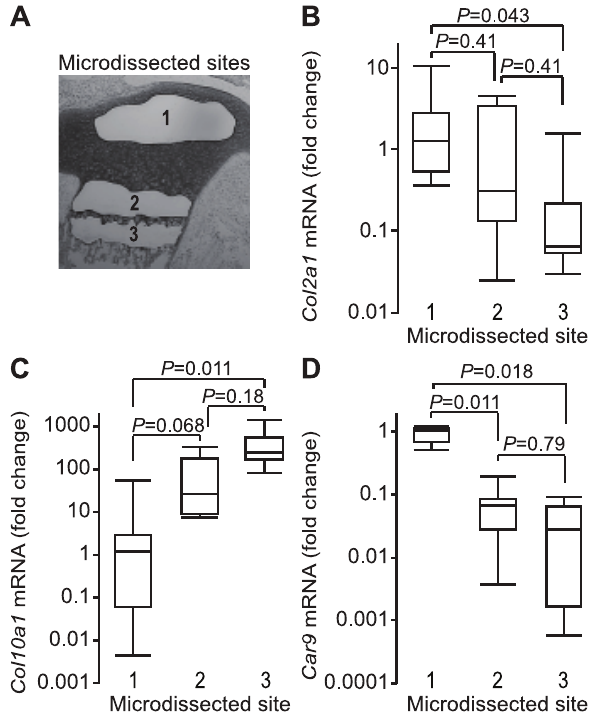
Figure 2. Expression of Car9 mRNA in epiphyseal cartilage. Frozen sections of lower limbs excised from 1-day-old postnatal ddY mice were laser microdissected ( A ) and analyzed for the mRNA expressions of Col2a1 ( B ), Col10a1 ( C ), and Car9 ( D ). A. Regions consisting of round-shaped proliferating chondrocytes ( 1 ), columnar proliferating and pre-hypertrophic chondrocytes ( 2 ), and hypertrophic chondrocytes ( 3 ) were isolated from epiphyseal cartilage sections sliced by laser microdissection. B. Expression of Col2a1 mRNA in the microdissected specimens ( 1 , 2 , 3 ). C. Expression of Col10a1 mRNA in the microdissected specimens ( 1 , 2 , 3 ). D. Expression of Car9 mRNA in the microdissected specimens ( 1 , 2 , 3 ). The expression of Col2a1 , Col10a1 , and Car9 were quantitatively analyzed by real-time RT-PCR. The expression level of each gene was normalized to that of Gapdh and expressed as a value relative to that obtained in region 1 . Data are expressed by boxplots (the sample maximum, the upper quartile, the median, the lower quartile, and the minimum observation). P -values obtained by Steel-Dwass test were indicated (n=6).